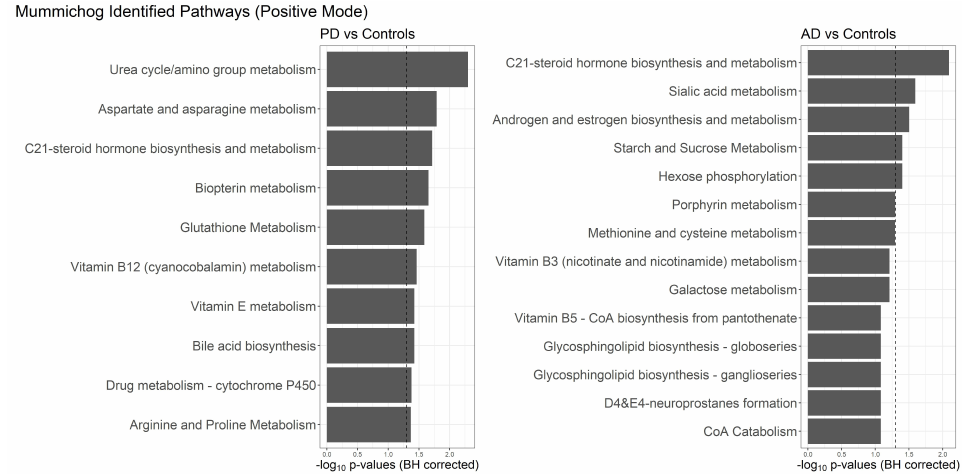
Figure 3. Pathway Analysis of Mummichog on the positive mode untargeted metabolites from univariate logistic models classifying PD and AD against Controls, sorted by − log Hochberg corrected p -values, with the vertical dashed line marking p =